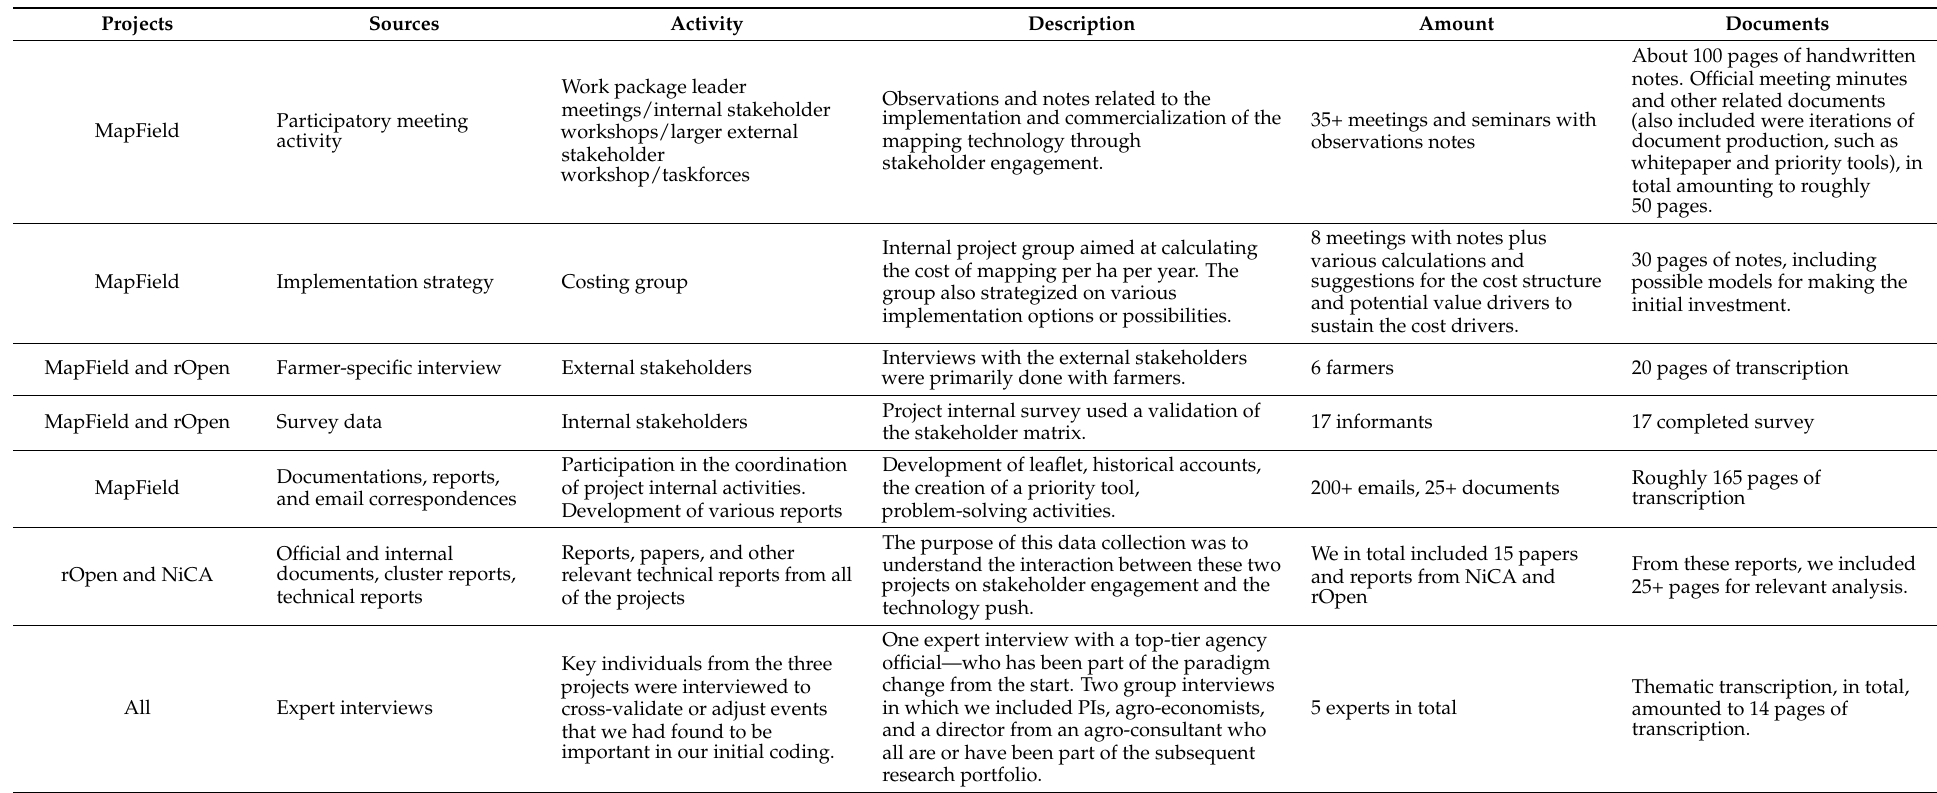
Table 1. Overview of data